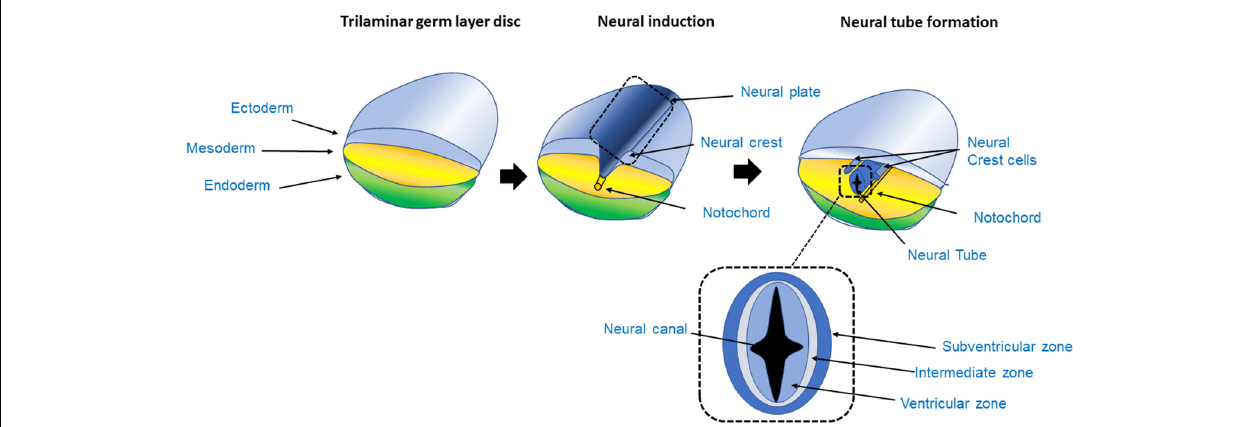
FIGURE 1 | Process of neurogenesis. The CNS originates from the ectoderm layer of the trilaminar germ disc. The process of neurogenesis begins with the formation of the neuroepithelium from the neuroectoderm, giving rise to the neural tube in a process called primary neurulation (Johns, 2014). The trilaminar germ layer disc is composed of the three germ layer tissues, the endoderm, mesoderm and ectoderm. The mesoderm gives rise to the notochord, a tubular mesodermal structure which on releasing trophic factors, triggers neural induction, whereby uncommitted or naïve ectoderm becomes committed to the neural lineage, and subsequently stimulates the formation of the neural tube in the overlying ectoderm (Dickinson et al., 1995). As the ectoderm acquires a neuroectoderm identity, it forms a fold, initially giving rise to the neural plate and subsequently forms the neural fold. The grooves at either side of the fold are called the neural crest. The crest then detaches from the margins of the neural fold giving rise to the peripheral nervous system. The neural plate continues to fold on itself giving rise to the hollow neural tube; the lumen of the neural tube is called neural canal. As the neural tube closes, it forms a fluid filled cavity that generates the ventricular zone, an area occupied by progenitor cells such as neuroblasts and glioblasts (Johns, 2014; Brodal, 2016; Kelava and Lancaster, 2016a). In the transverse section of the neural tube the VZ, intermediate zone and subventricular area can be seen. In the VZ mitosis takes place generating radial glia during